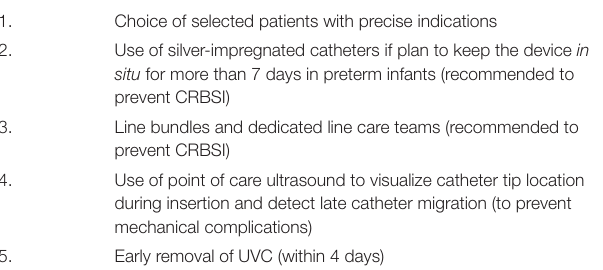
TABLE 2 | Correct steps in UVC